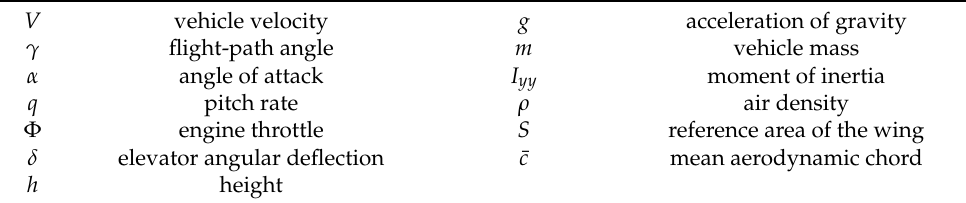
Table 1. States, inputs and physical